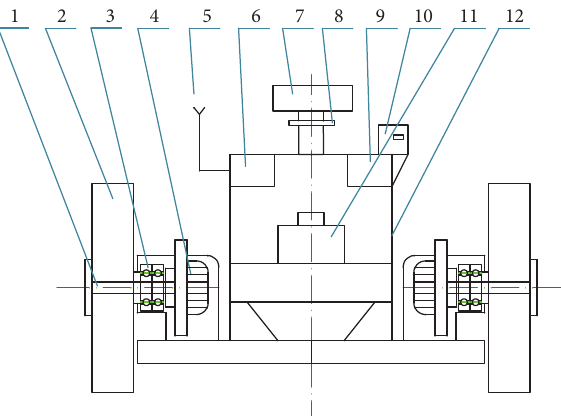
Figure 2: Structure diagram of intelligent safety monitoring robot for coal mine shaft construction. (1) Actuating shaft; (2) driving wheel; (3) ball bearing; (4) driving motor; (5) transmitting antenna; (6) communication device; (7) image acquisition device; (8) tripod head; (9) control device; (10) intelligent sensing device; (11) neg- ative pressure adsorption device; (12) shell.